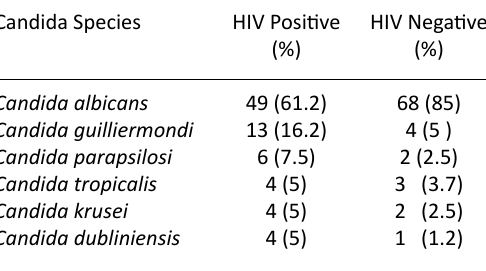
Table 5. Sensitivity profile of isolated candida species to various antifungal agents